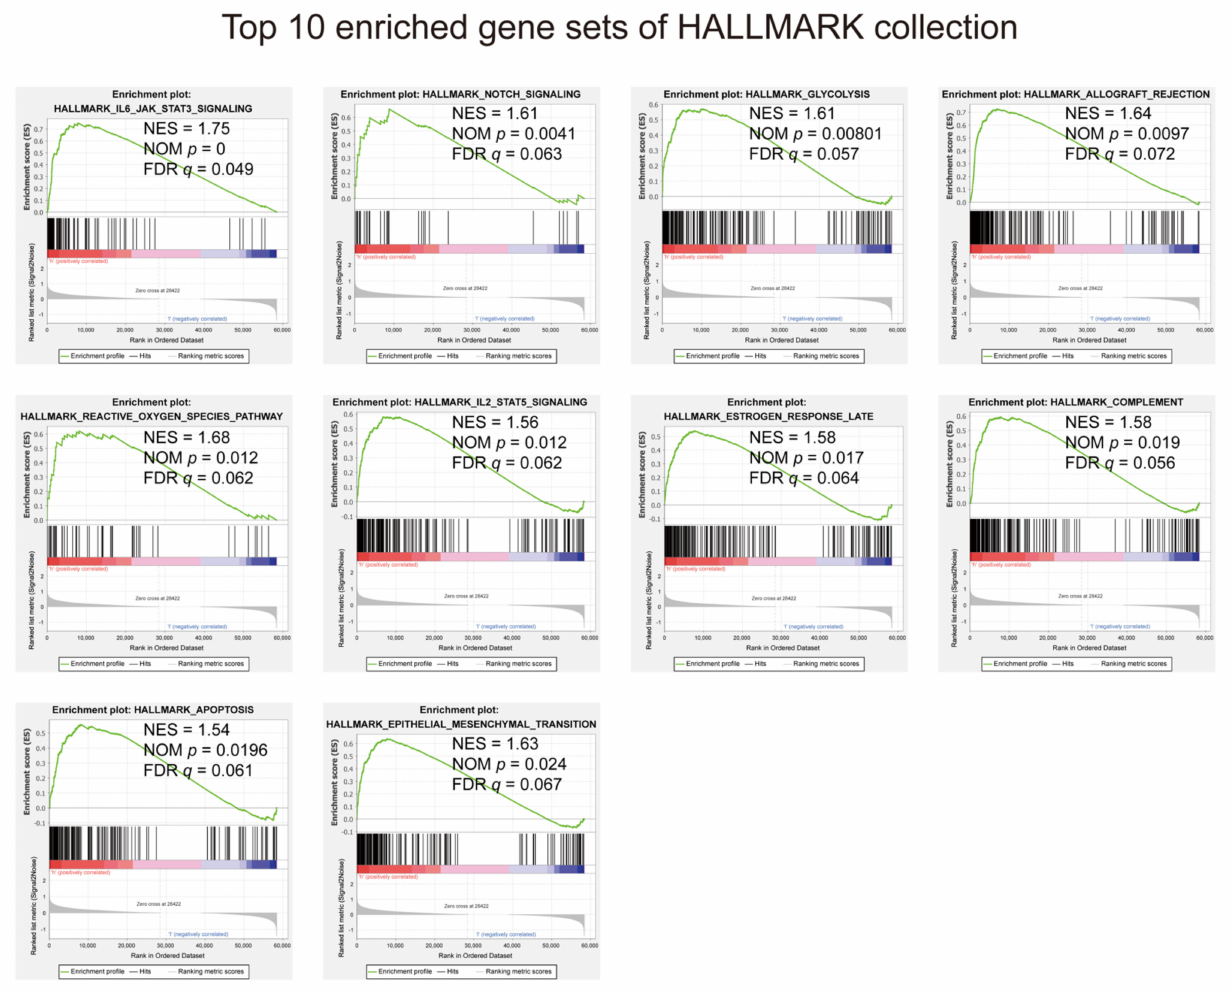
Figure 8. Gene set enrichment analysis performed using HALLMARK collection. |NES| > 1, NOM p < 0.05, and FDR q < 0.25 are set as the significance